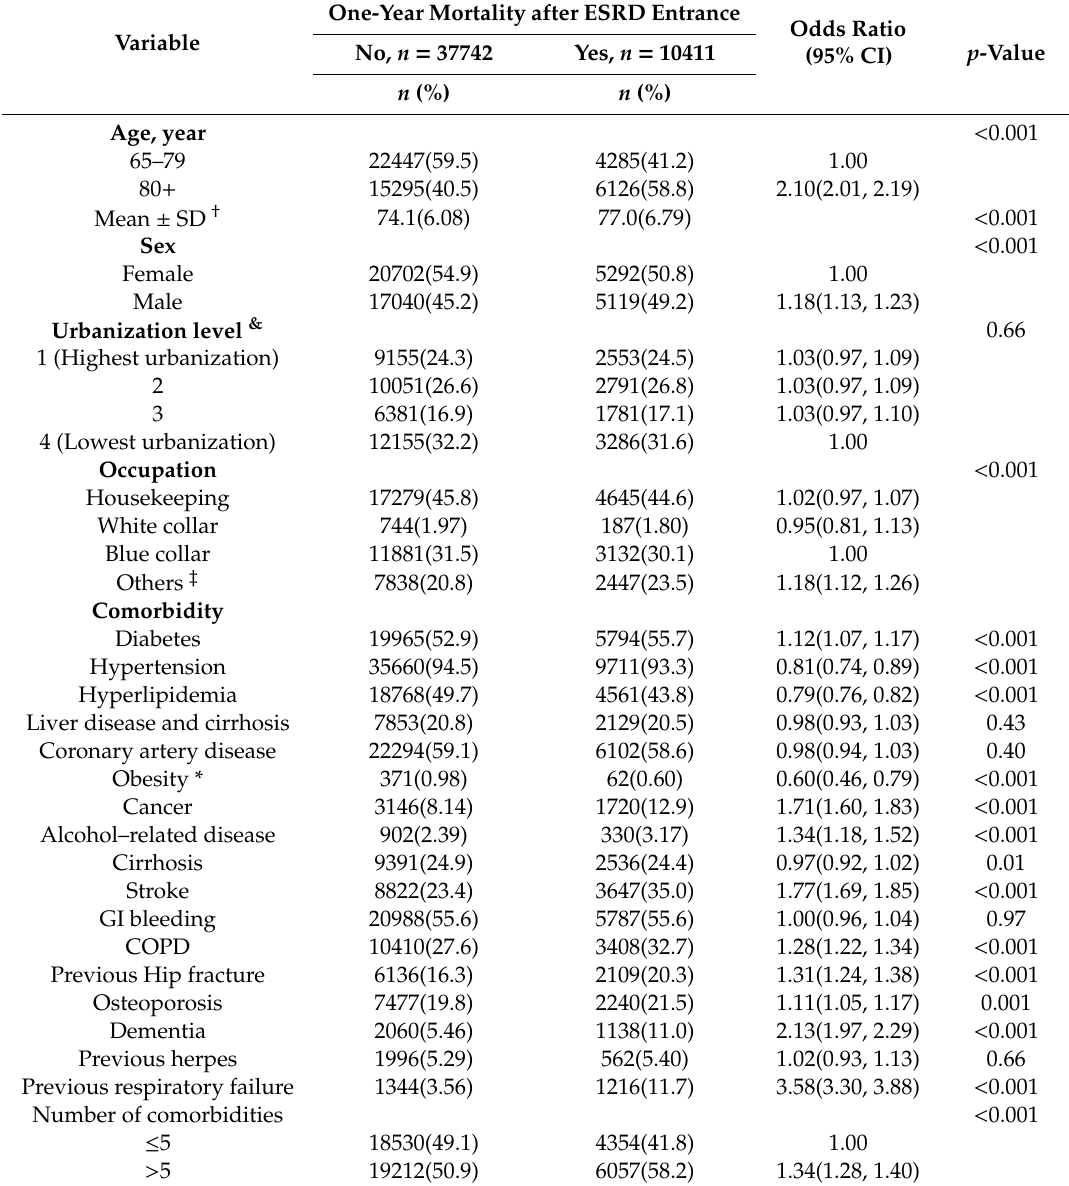
Table 2. Demographic characteristics and comorbidities between patients with one-year mortality or without one-year mortality after ESRD entrance; Individual odds ratio of baseline demographic and comorbidities for one-year mortality after ESRD